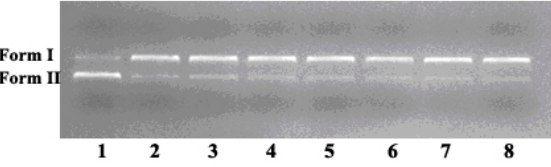
Figure 11. Electropherograms representing cleavage of pUC19 plasmid DNA (0.008 µg/µL) in buffer of different weight ratios of GO to complex 2c (6.25 × 10 − 7 mol/L, 5 mM Tris-HCl/10 mM NaCl, pH = 6.0) at 37 °C for 8 h. Lanes 1–7: complex 2c alone, 0.5, 1.0, 2.0, 3.0, 4.0, 5.0, respectively and Lane 8 is DNA control with GO (0.67 µg/µL), respectively.